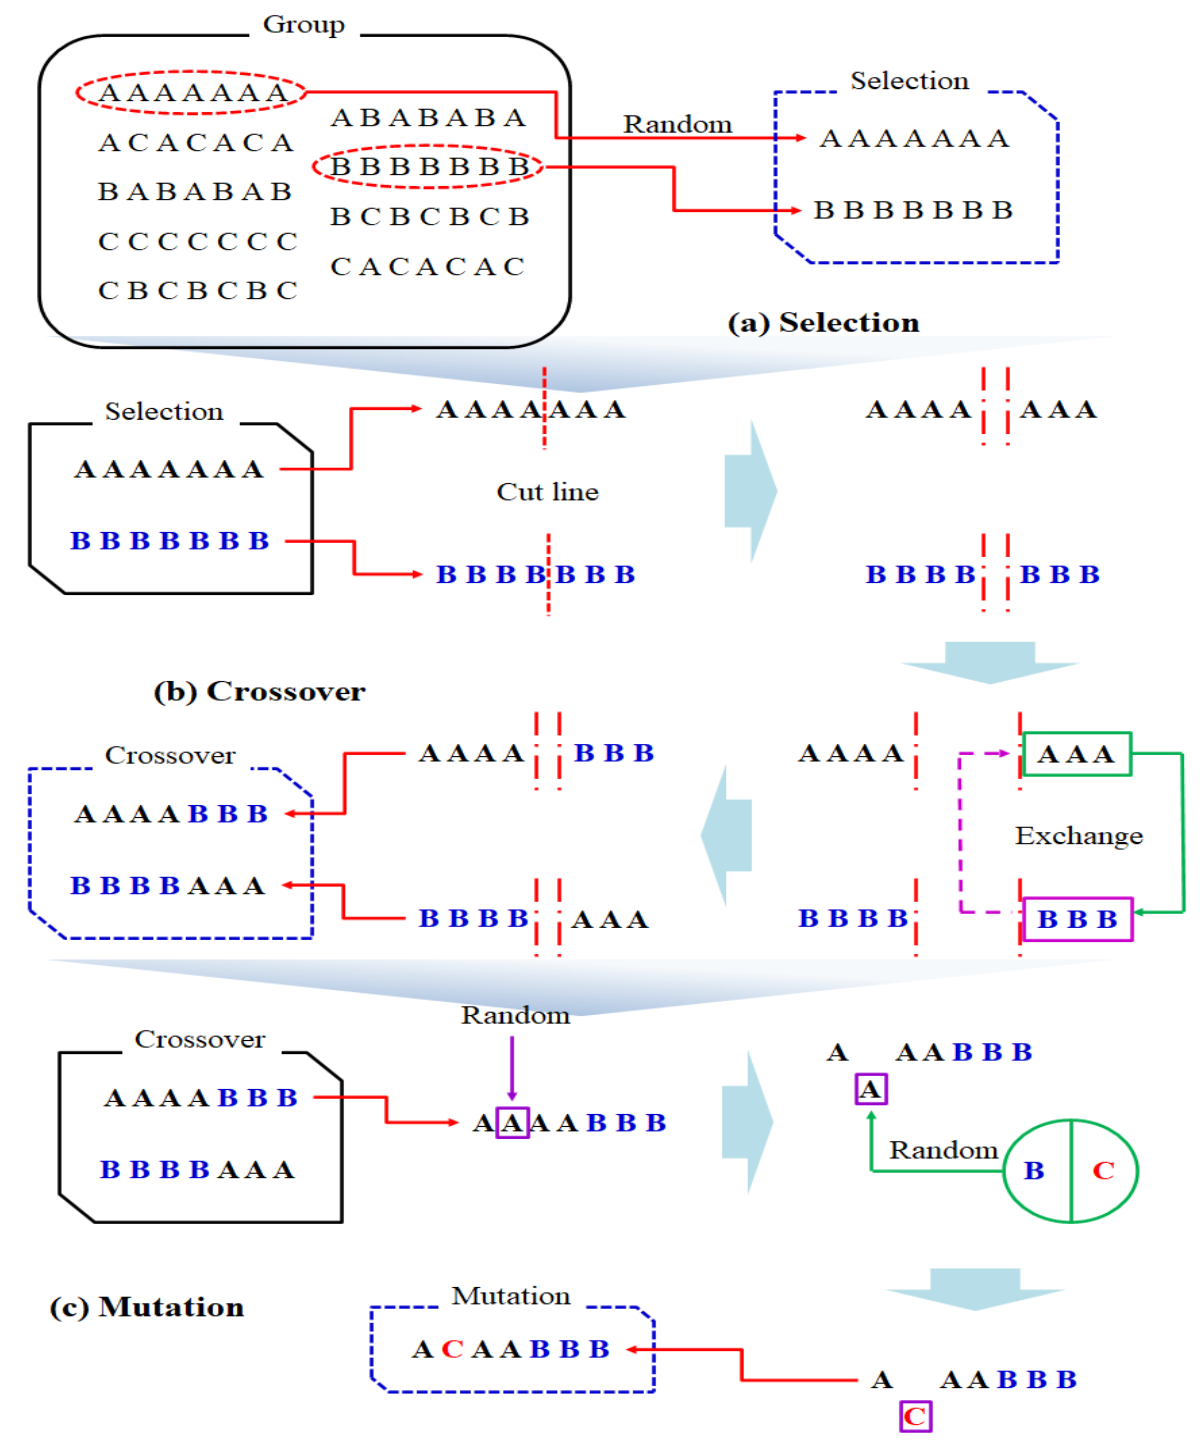
Figure 2. Selection, crossover, and mutation.